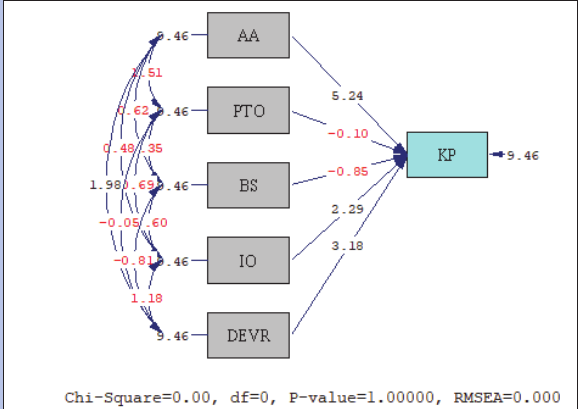
Fig. 2. The Result of Significance